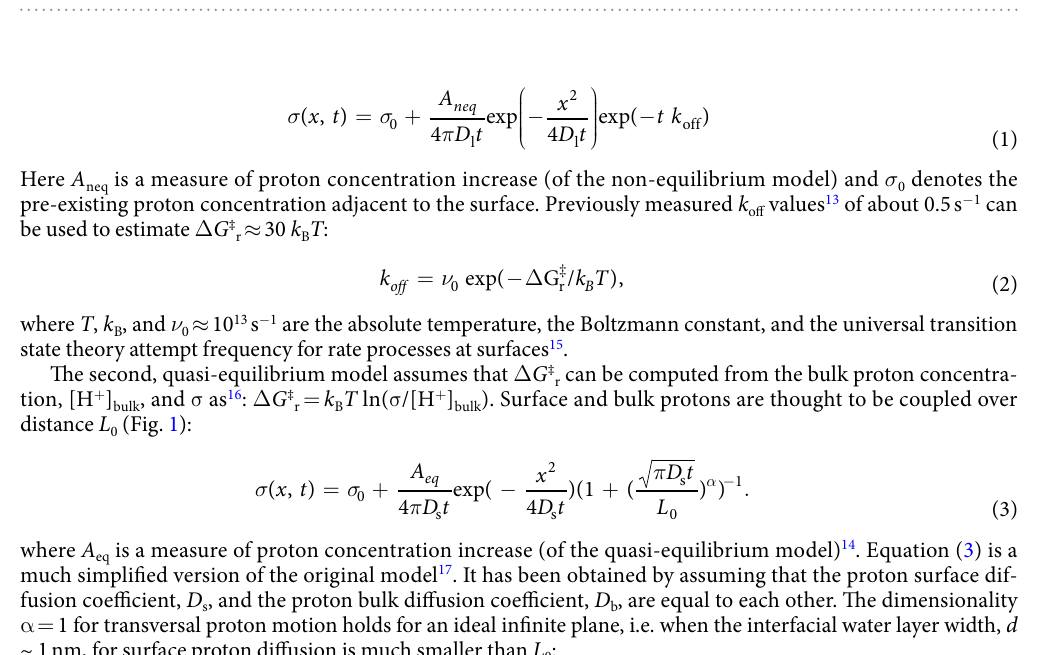
Figure 1. Schematic of the two different models for proton migration along the membrane surface. The non- equilibrium model ( a ) envisions proton diffusion within the confinement of the membrane hydration layers without the involvement of titratable residues on the surface. Proton surface-to-bulk release is thought to be irreversible (equation (1)). The quasi-equilibrium model ( b ) treats proton surface diffusion as a succession of jumps between titratable residues. The proton uptake and release reactions are in equilibrium. In the absence of real proton acceptors and donors, fictional moieties are assumed to take their place. Accordingly, their p K a value is obtained as a fitting parameter of the model (equations